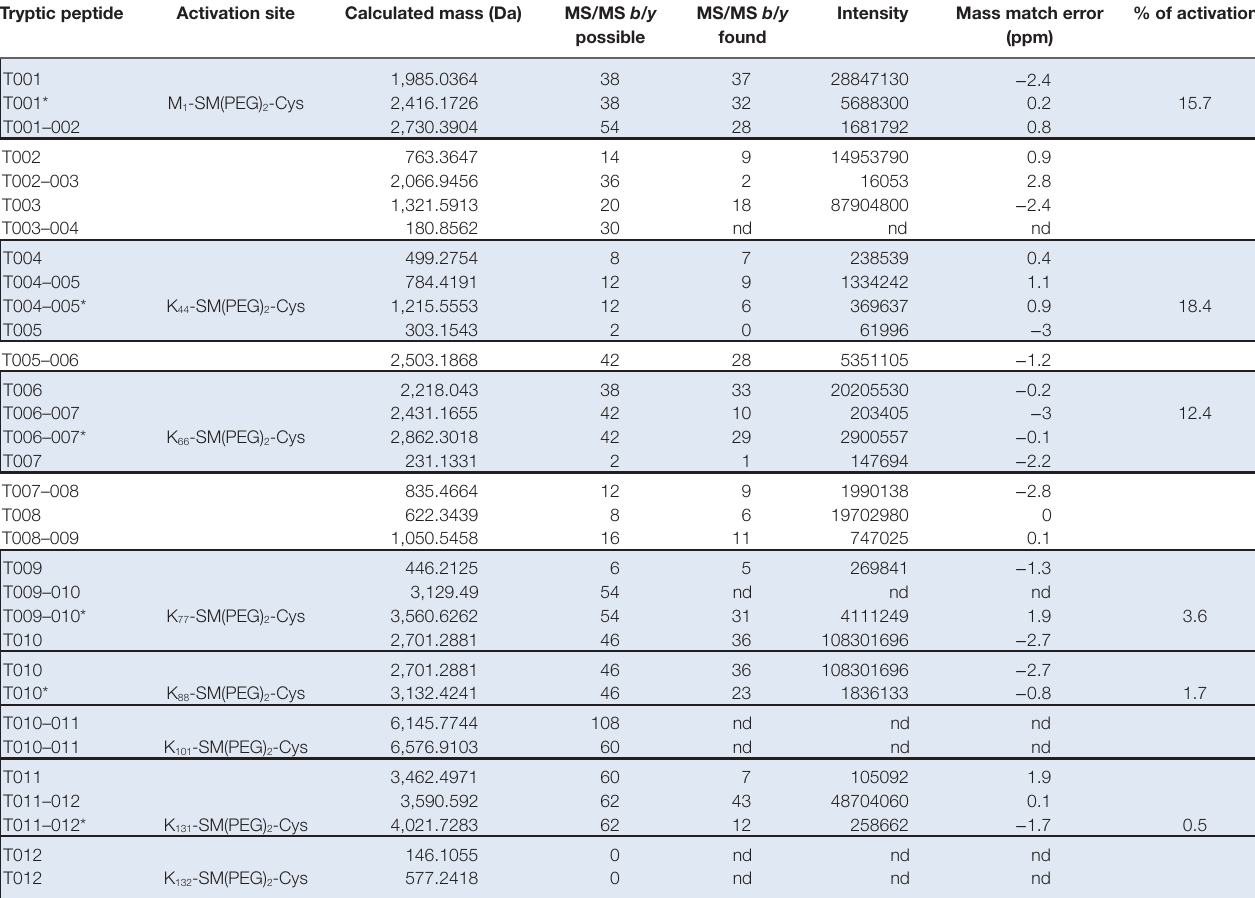
Thick boxes (also shaded blue) around sets of tryptic peptides indicate related groups of peptides used to calculate percentage of activation for each activation site. nd, not detected. *indicates the modified version of the